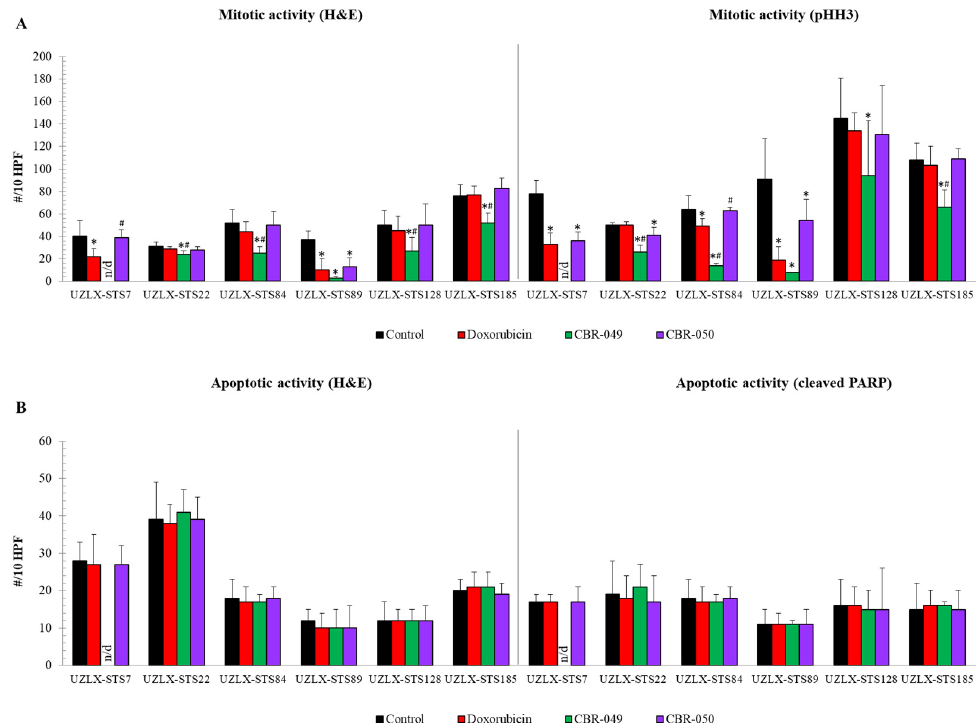
Figure 3. Assessment of mitotic and apoptotic activity of tumors collected at the end of experiment (day 36). ( A ) Mitotic cell count assessed on H&E and pHH3 staining; ( B ) Apoptotic cell count assessed on H&E and cleaved PARP staining. Data are presented as average ± standard deviation. CBR ‐ 049 ‐ treated samples from UZLX ‐ STS7 could not be assessed because of a technical problem that occurred during the embedding of the formalin ‐ fixed tumors in paraffin. * p < 0.05 as compared to control; # p < 0.05 as compared to doxorubicin. H&E: hematoxylin and eosin; pHH3: phospho ‐